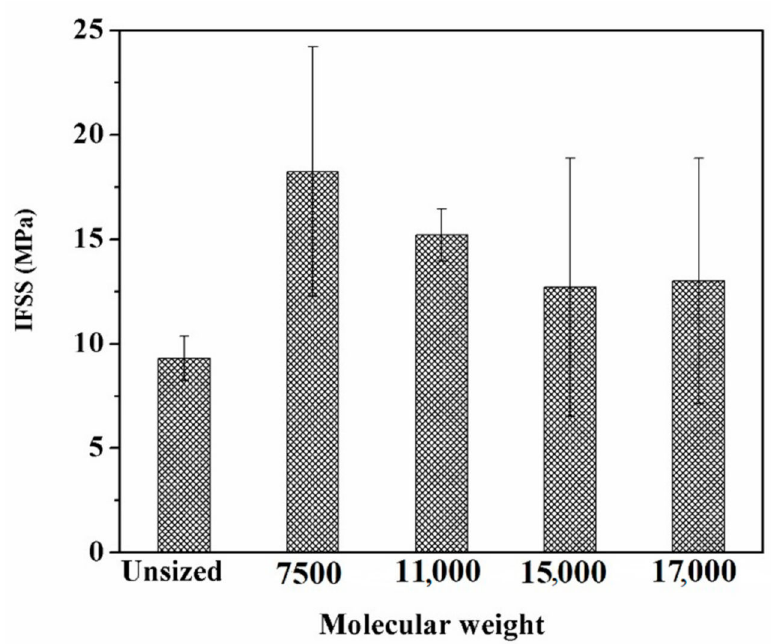
Figure 13. Interfacial shear strength of unsized CFs and sized CFs by emulsions with the four di ff erent molecular weights.